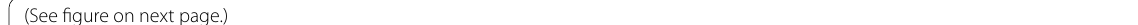
(See figure on next Fig. 4 Proteins altered in CACs incubated with asymptomatic patients’ serum compared with negatives and functional network. A Graphical representation of the label‑free quantification (LFQ) intensities registered for several proteins altered in CACs (n:8) compared to CACs Neg controls (n:8). Differences were considered significant when p‑values < 0.05. *p‑value < 0.05, *p‑value < 0.01, + *p‑value < 0.001. B Receiver operating characteristic (ROC) analysis of HSPA5, STAB1, RAB10 and TMP3 proteins in asymptomatic COVID‑19 patients with area under curve (AUC). C Naïve Bayes classifier